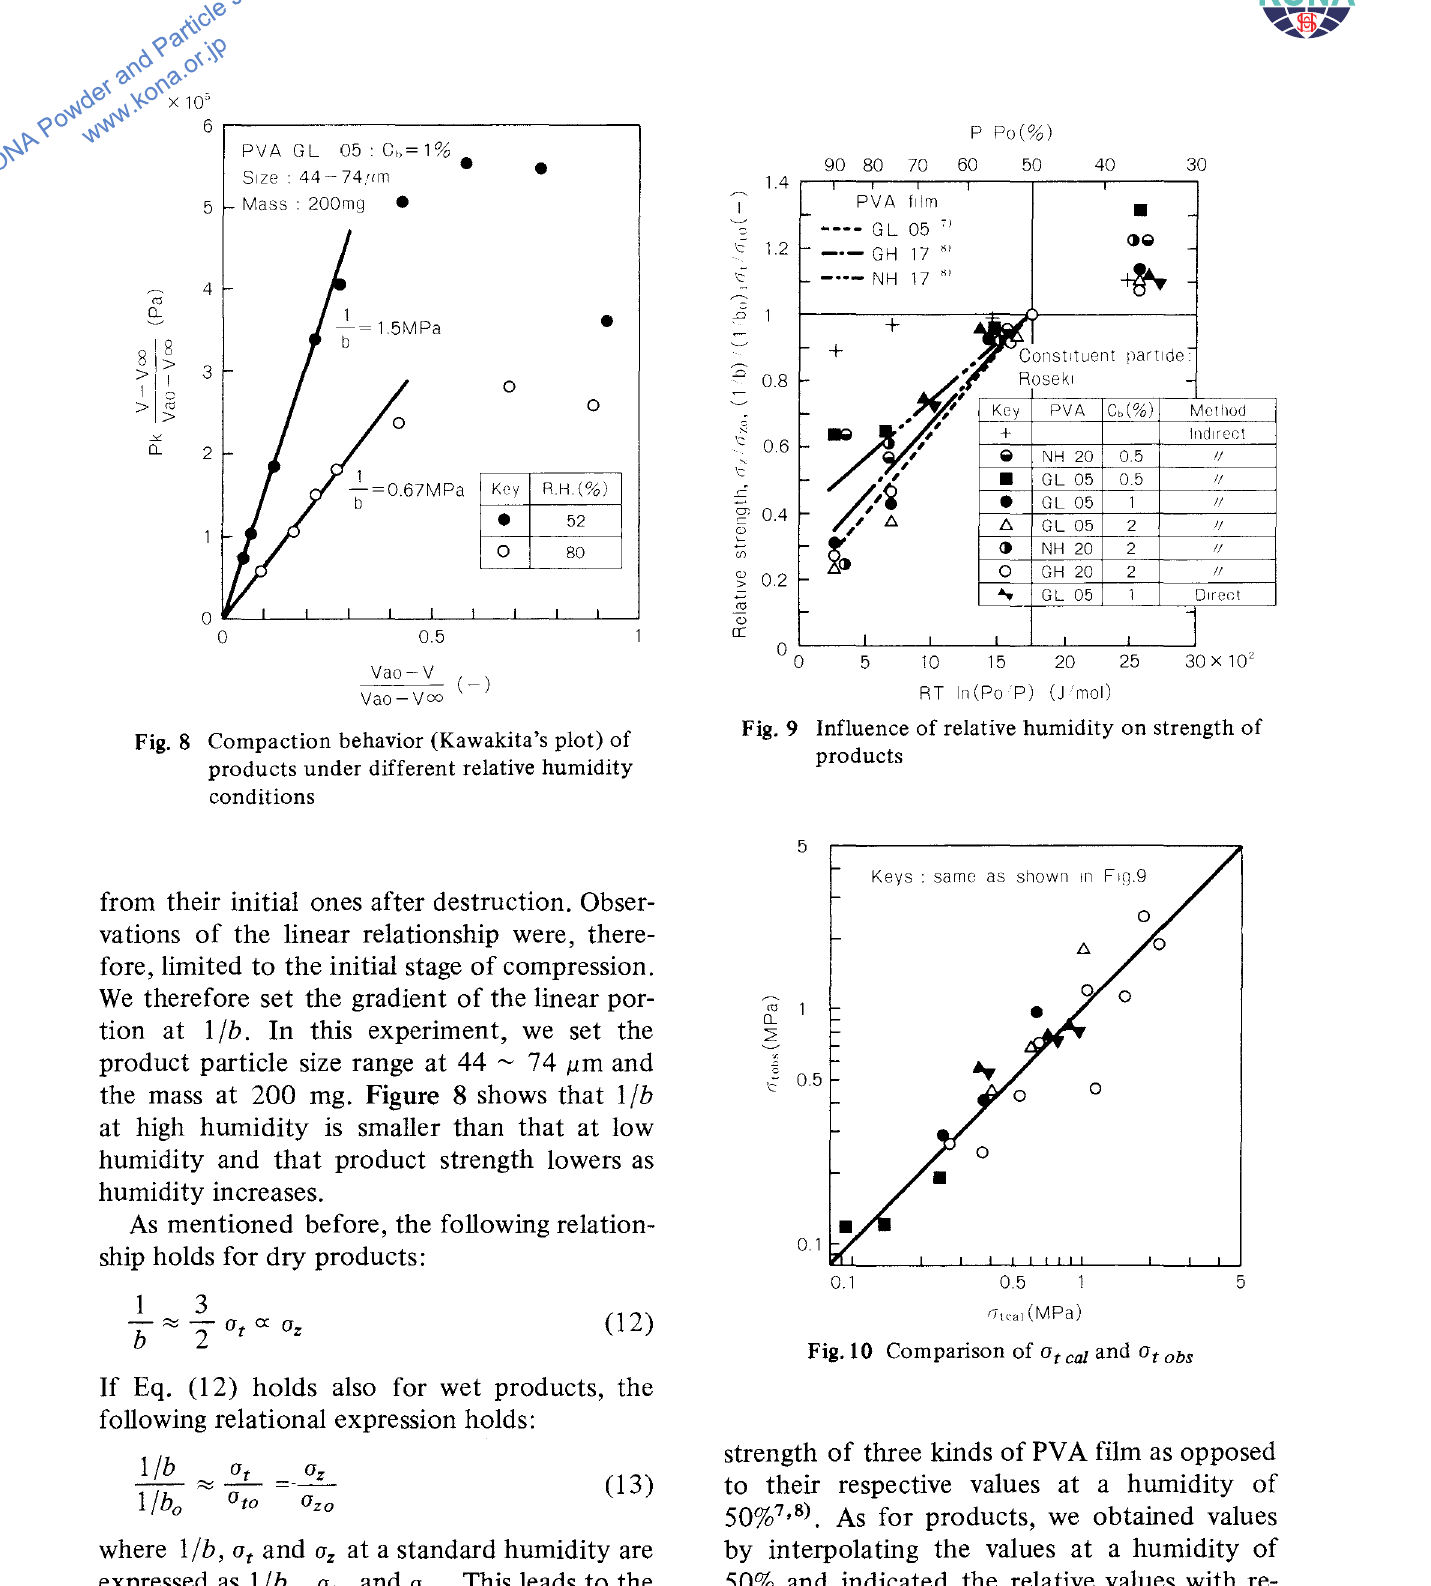
strength of three kinds of PV A film as opposed to their respective values at a humidity of 50% 7 •8 ). As for products, we obtained values by interpolating the values at a humidity of 50% and indicated the relative values with re gard to the above values. As is evident from this figure, the relative strength of products declines as humidity increases and that this trend almost agrees with that in PV A